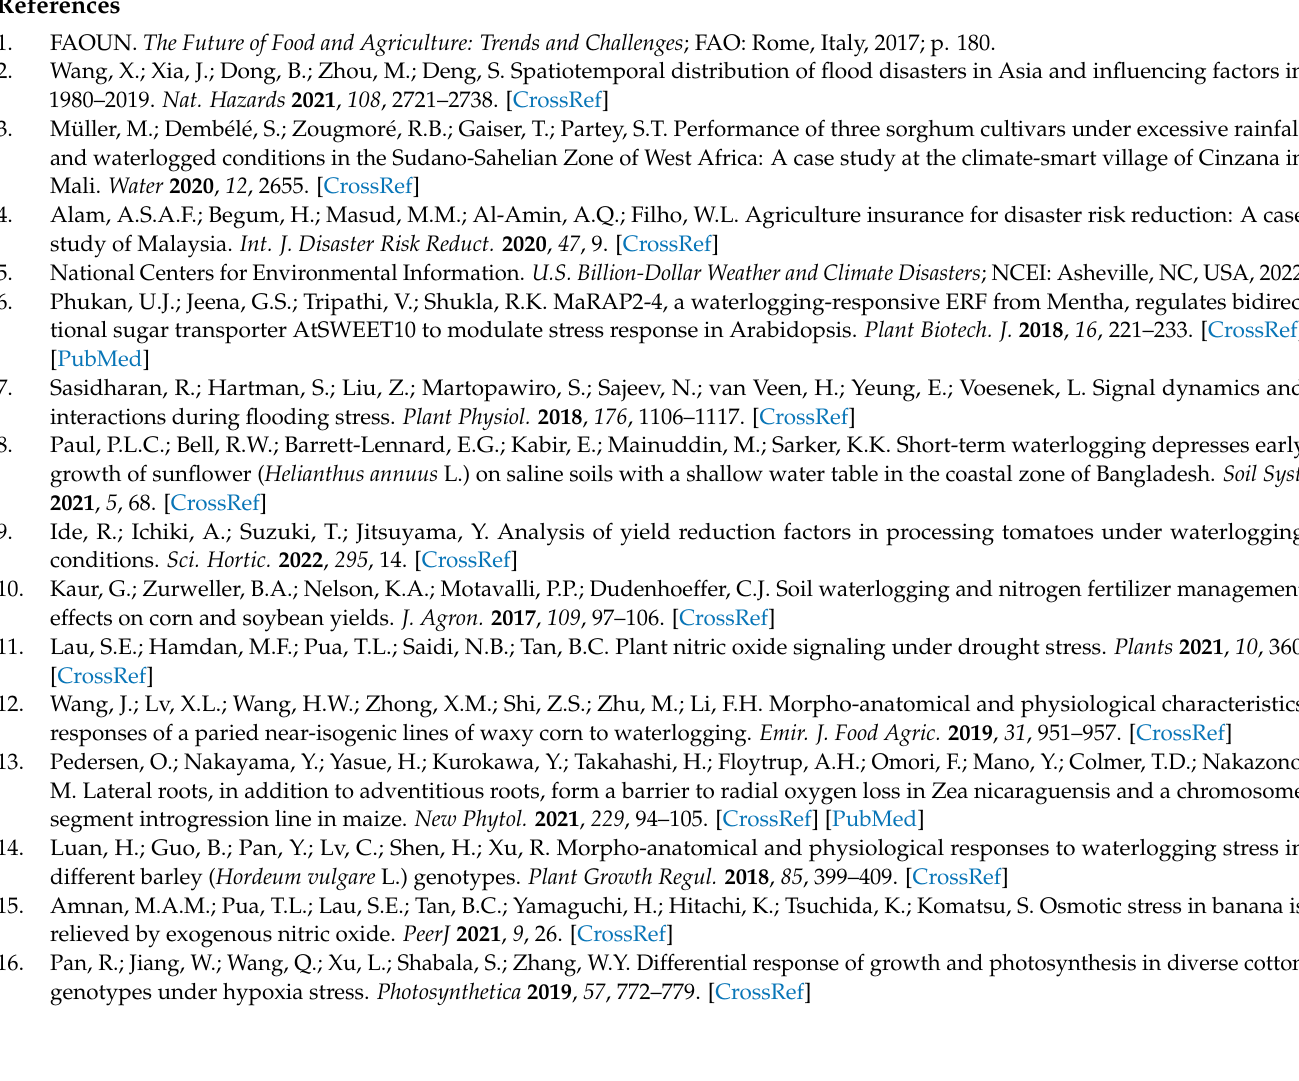
Table S4: Total reads and mapped reads for well-watered and waterlogged bananas; Table S5: The list of significantly differentially expressed genes; Table S6: Sequences of primers, banana genome hub gene ID, and the product length of the